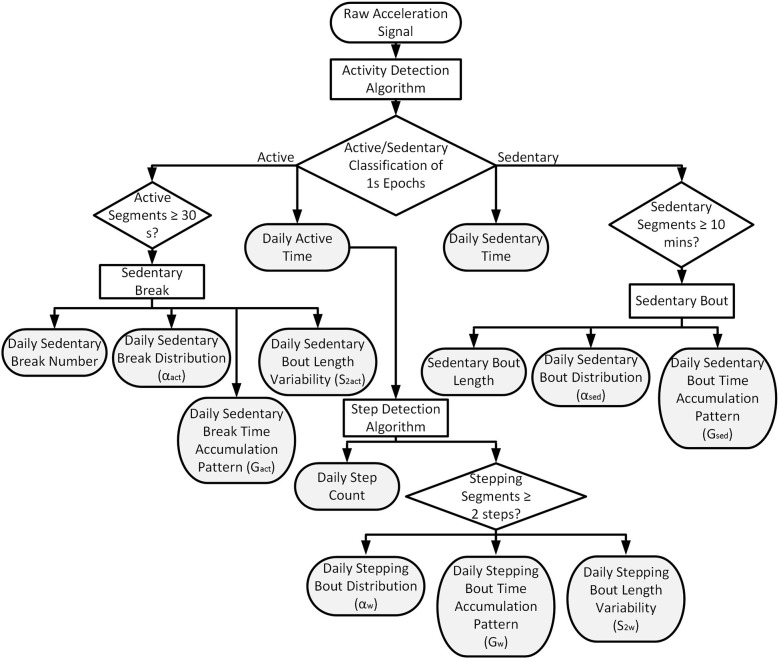
Schematic flowchart describing the algorithm steps. The filled-in gray blocks mark the 13 physical activity and sedentary behavior outcome measures.